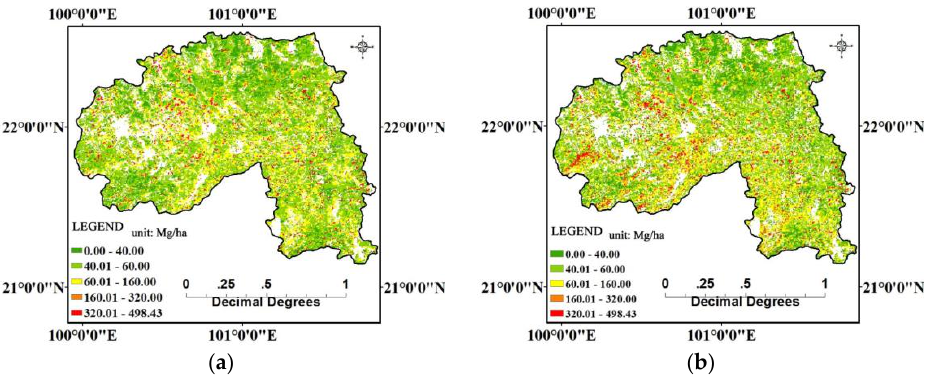
Figure 6. Biomass map of the Xishuangbanna forest area. ( a ) Canopy heights vs . biomass; and ( b ) canopy heights and LAIs vs. biomass.